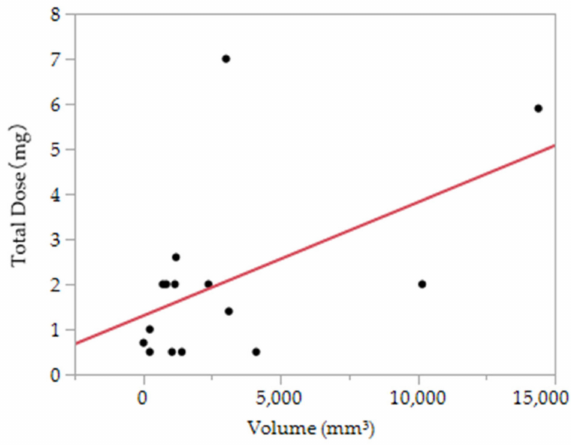
Figure 3. The association between the volume and total dose of